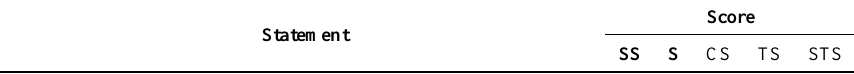
Table A3. Children's Mental Resilience Questionnaire